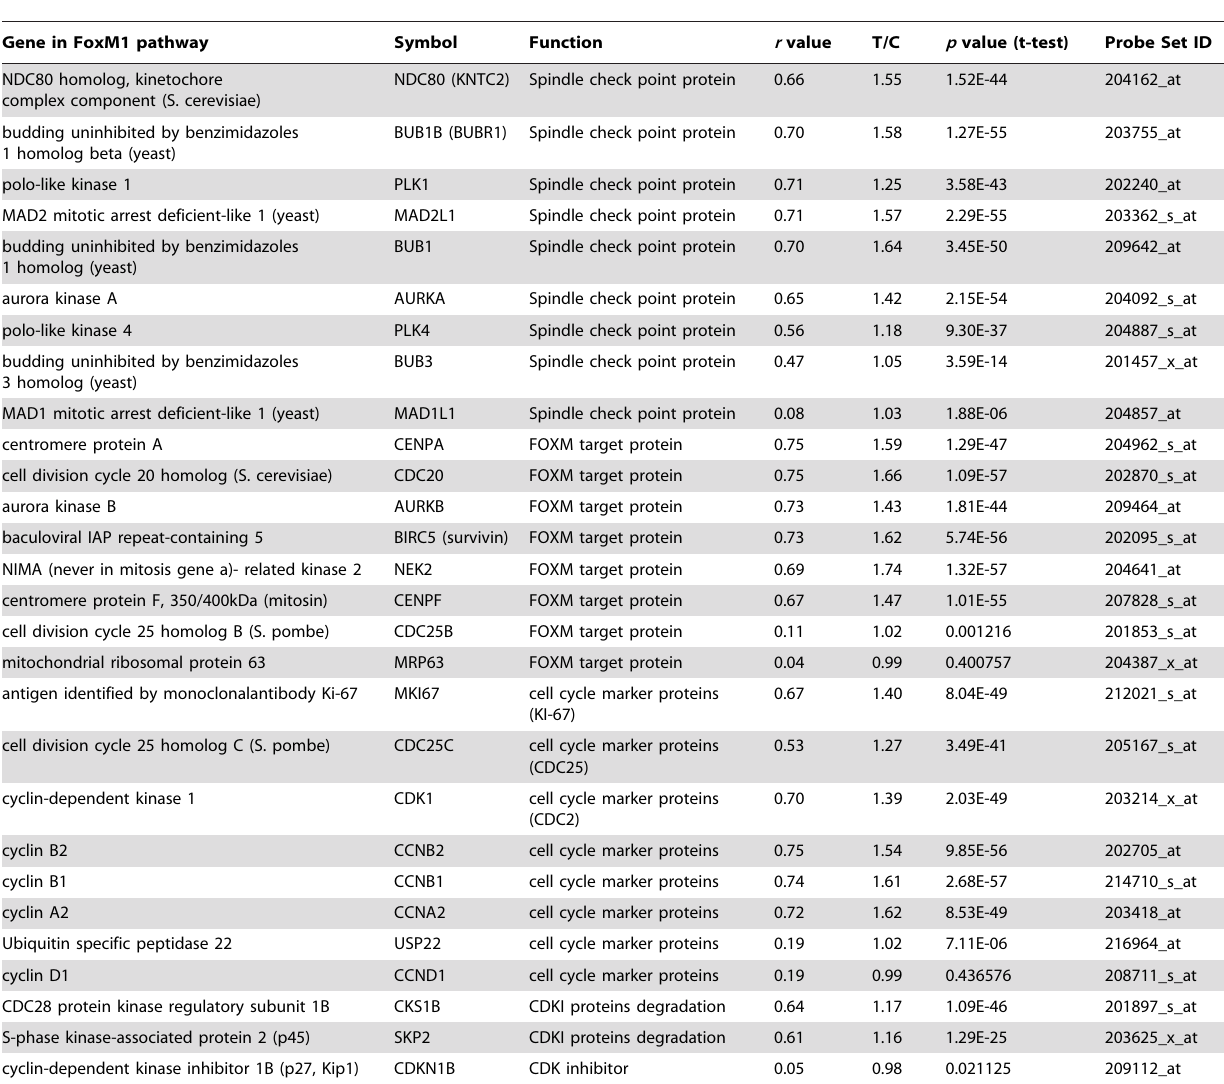
Table 2. Correlation of gene expression between FoxM1 related genes and GAPDH in NSCLC.